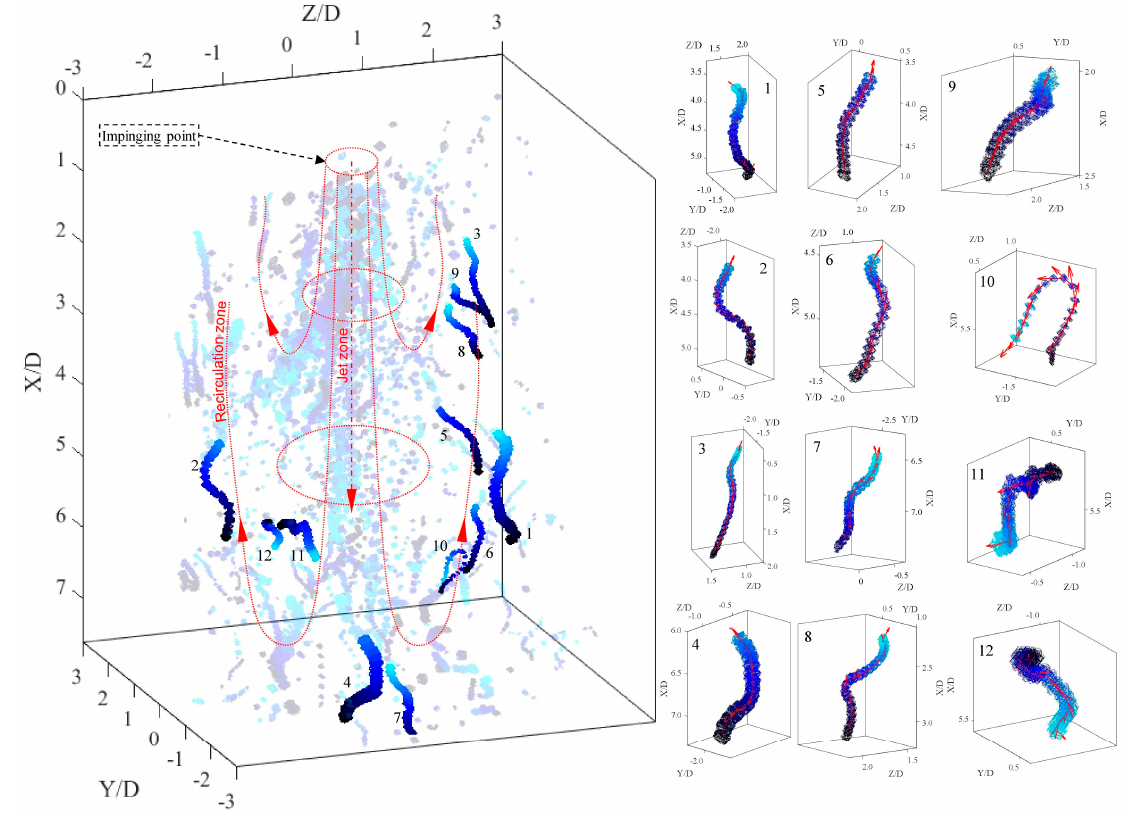
Figure 5. Sequence of air bubbles entrained by the vertical plunging jet and reconstructed by means of the volumetric shadowgraph technique. The plunging jet is downward from the top, with X / D = 0 indicating the water